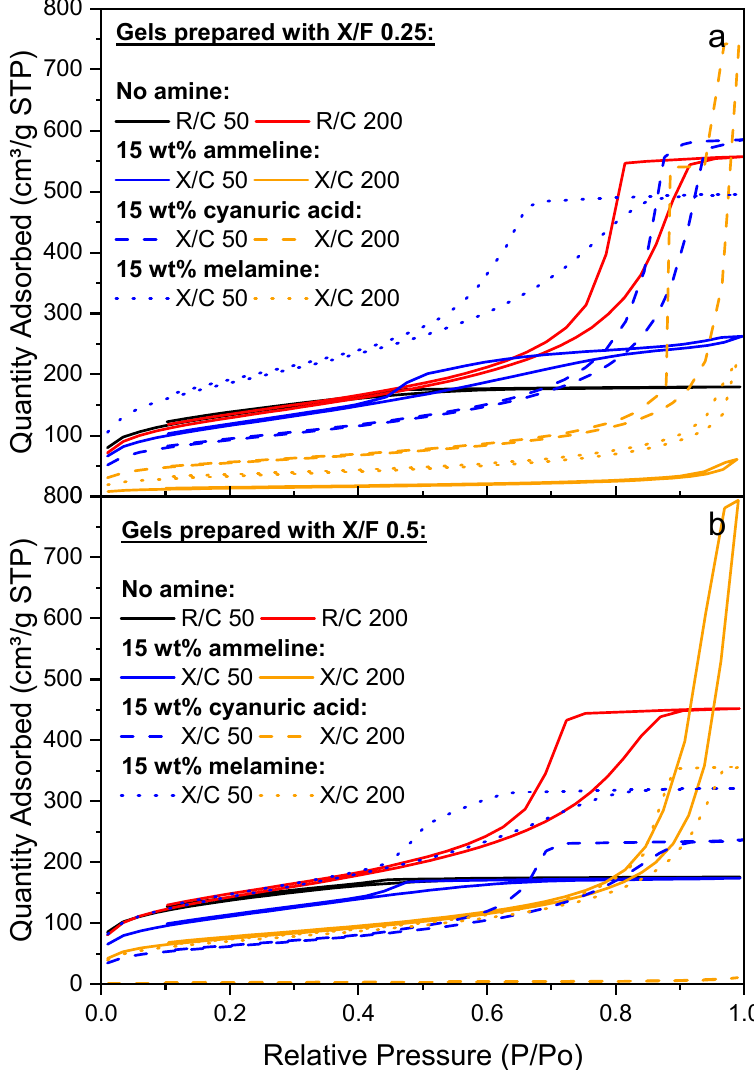
Figure 7. Nitrogen sorption isotherms for gels prepared with 15 wt% of additives and with ( a ) X / F 0.25 and ( b ) X / F 0.5.